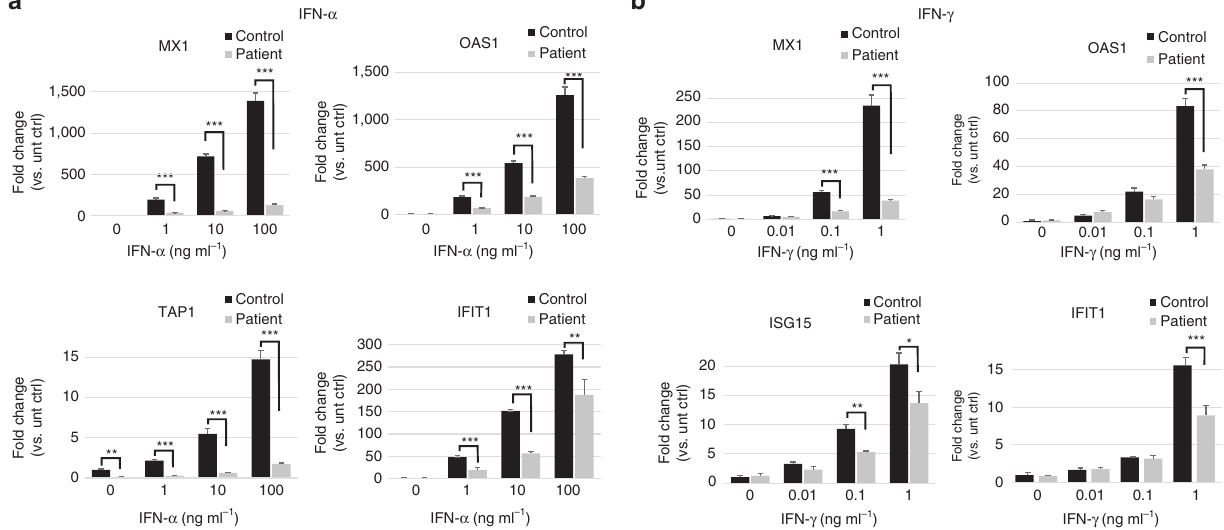
Figure 4 | Patient’s fibroblasts show reduced induction of gene expression after IFN- a and IFN- c stimulation. Cells were stimulated with IFN- a for 15h ( a ) or IFN- g for 8h ( b ). qPCR was done in triplicate. mRNA fold change is shown relative to the untreated control fibroblasts. * P o 0.05, ** P o 0.005, *** P o 0.0005. Graphs show mean values ±